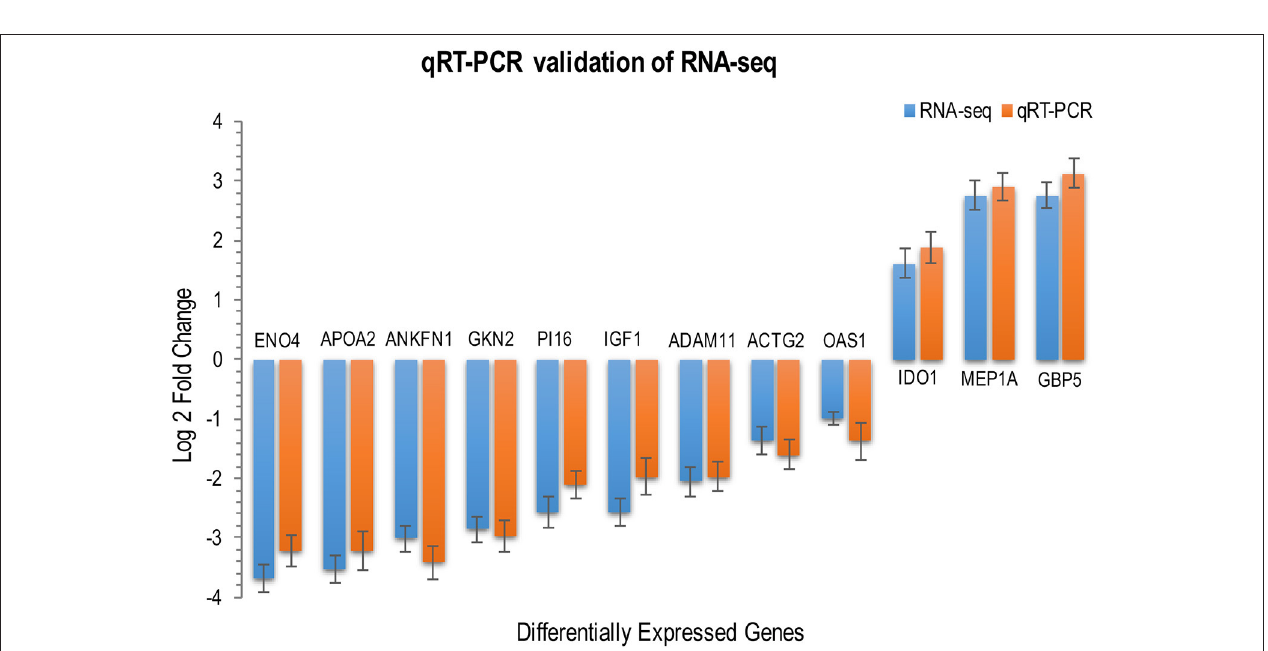
FIGURE 2 | RNA-seq transcriptome analysis and quantitative, real-time RT–PCR produced similar gene expression profiles. The expression levels of 12 DEGs across various cat tissues were determined by qRT-PCR for validation of RNA-seq data. Relative expression levels were calculated using the the 11 C T threshold cycle (C T ) method and GAPDH as the reference gene. RNA-seq data are mean of two biological replicates + standard deviation (SD) of normalized read counts. qRT–PCR data are mean of three biological replicates + SD. P values are calculated with unpaired, two-tailed t -test. The height of the bars represents the log-transformed median fold changes in gene expression between infected and uninfected